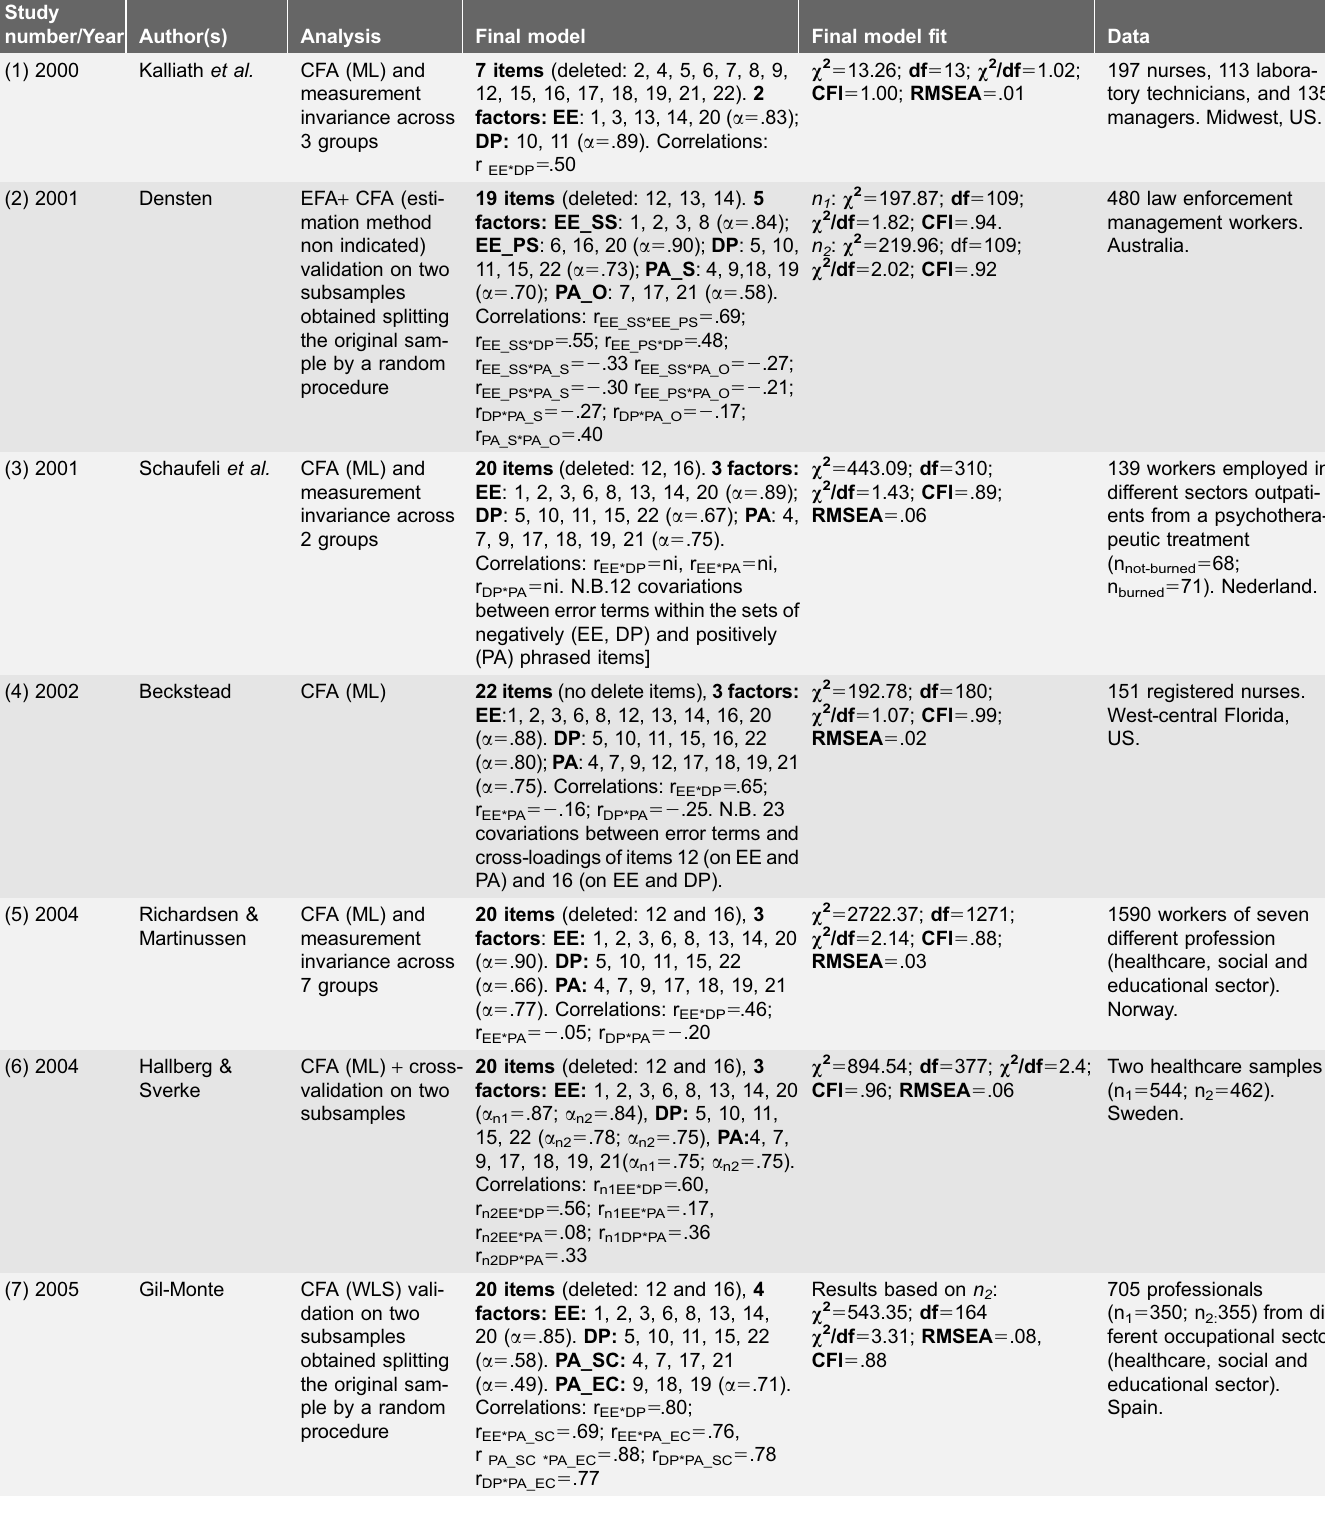
Table 1. Systematic review of the main studies on MBI-HSS